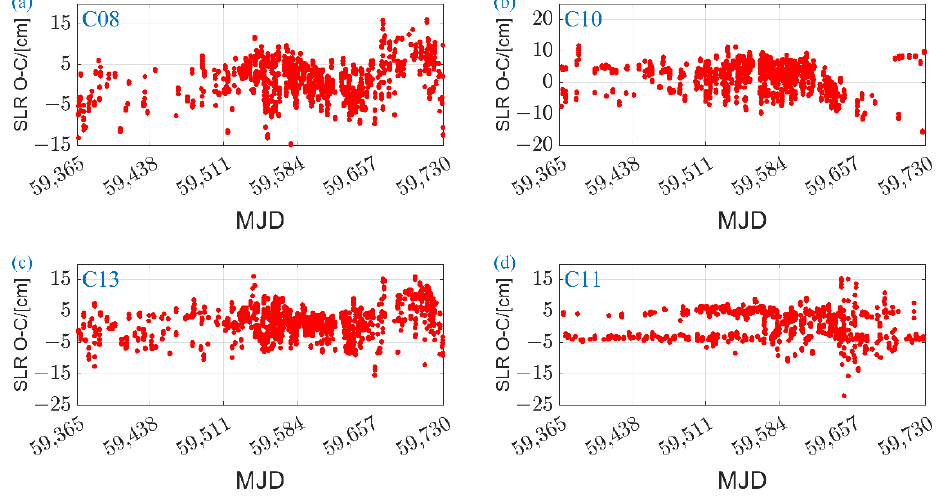
Figure 21. SLR validation results of BDS-2 ( a ) C08 (I3), ( b ) C10 (I5), ( c ) C13 (I6) and ( d ) C11(M3) orbits.